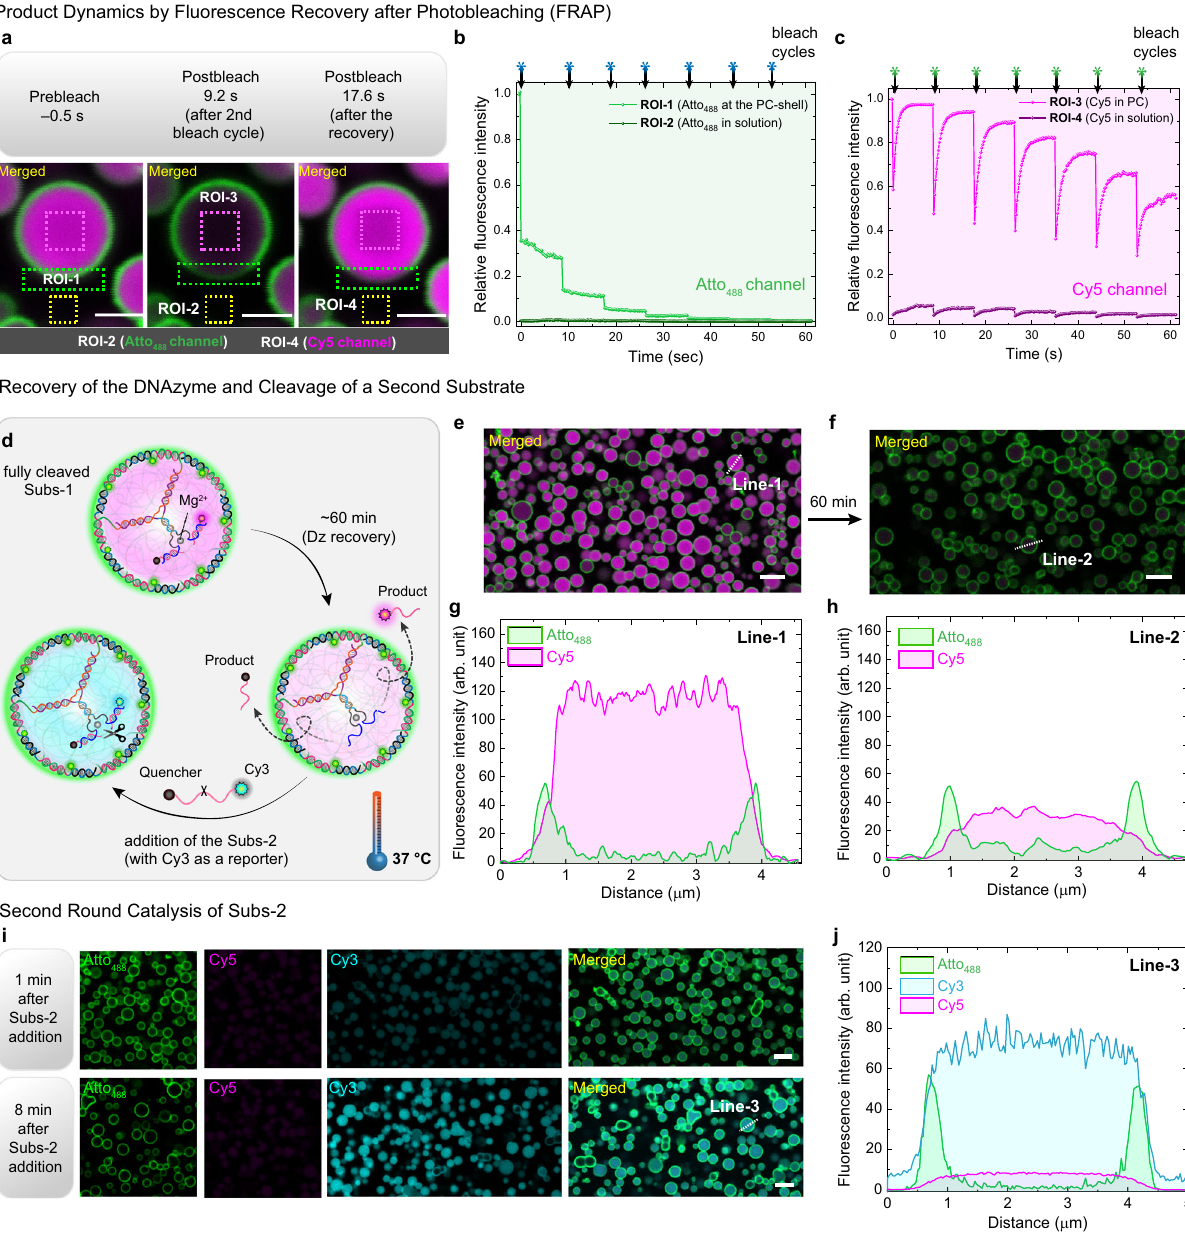
Fig. 3 CLSM investigation of intra-protocellular product diffusion and catalyst recovery. a CLSM image of a Dz ⊂ PC after the completion of DCBC of Subs-1 and the photobleaching is performed within the dotted rectangles. The row of CLSM images depicts the pre-bleach state, the post-bleach state immediately after the second bleach cycle, and another post-bleach state after the recovery, hence just before the third bleaching cycle. b The relative fl uorescence intensities from ROI-1 and ROI-2 (green channel for Atto fl uorescence intensities from ROI-3 488 ) over the seven bleach cycles. c The relative and ROI-4 (magenta channel) over seven bleach cycles, depicting Cy5 fl uorescence recovery. The black downward arrows represent the bleaching events. Scale bars: 3 μ m. d Schematic representation of catalyst recovery after completion of the Subs-1 cleavage and the con fi rmation of the free DNAzyme active sites using Subs-2, a self-reporting substrate with a second fl uorophore (Cy3, cyan). e CLSM image of Dz ⊂ PCs with fully-cleaved Subs-1 (merged channel: Atto 488 and Cy5). f CLSM image of Dz ⊂ PCs after 60 min of Subs-1 addition. g , h The line segment analysis in both channels of Line-1 and Line-2, before and after the product release from PC core, respectively. i CLSM images Dz ⊂ PCs after the addition of Subs-2 ( t = 1 min and t = 8 min). Three channels represent the PC shell (green, Atto 488 ), the residual product of Subs-1 (magenta, Cy5), and the product generated from Subs-2 (cyan, Cy3). Scale bars: 5 μ m. j The line segment analysis of Line-3 of three channels. Conditions: [Dz ⊂ PCs] = 5 μ M, [Subs-1] and [Subs-2] = 12.5 μ M in TE buffer at pH 8. enhancement of the magenta fl uorescence, and (ii) that the DSD analysis of Atto 488 -n short * -labeled Dz ⊂ PC shows a rapid increase in reaction at the PC shell occurs via ejection of the Atto 488 -n short * from Cy5 fl uorescence (magenta channel) upon injection of Subs-3 (Fig. 4e), whereas the fl uorescence of Atto 488 (green channel) gra- the PC shell, resulting in a decrease of the green fl uorescence. It is dually decreases over time (Fig. 4d). These observations indicate that essential to realize that the product is now removed from any sub- (i) the Cy5-n * sequence is catalytically released from the input signal strate/product binding competition at the Dz in the PC interior by (Subs-3) upon DCBC and BCDM in the PC core, leading to an spatial relocalization into the shell. In a control experiment, when a NATURE COMMUNICATIONS| (2022) 13:3968